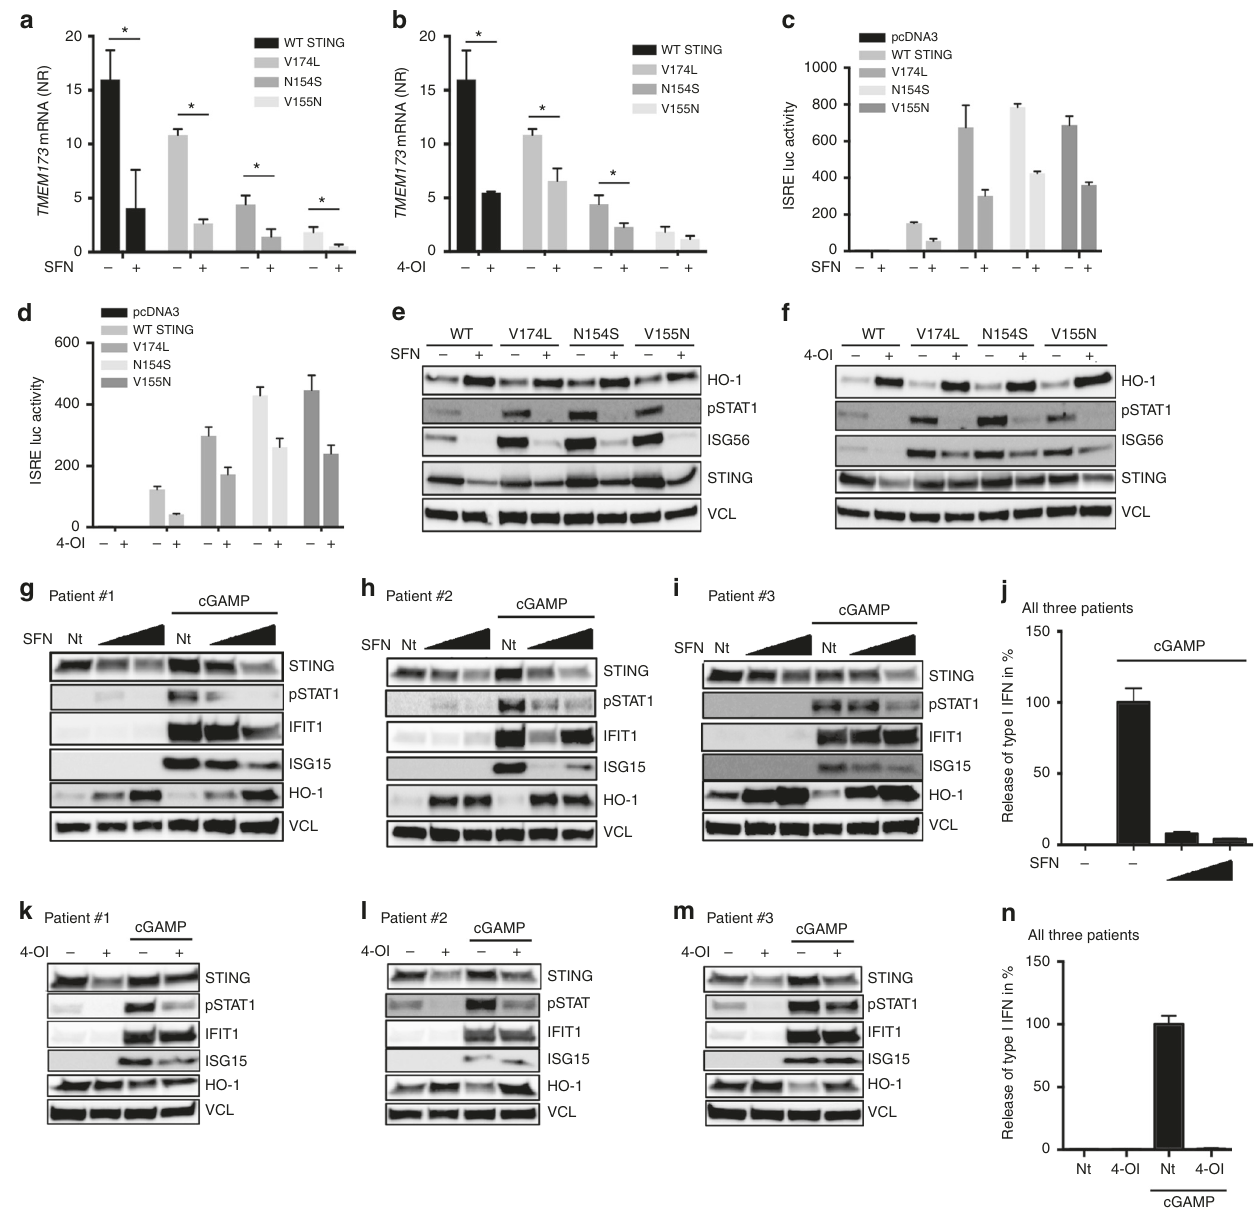
Fig. 5 Activation of Nrf2 suppresses STING-dependent type IFN response in fi broblasts from SAVI patients. a , b HEK293T were transiently transfected with human WT and SAVI-STING plasmids (V174L, N152S, or V155M) (500 ng/mL). Cells were treated 1 h prior transfection with SFN (10 μ M) or 4-octyl- itaconate (4-OI) (200 μ M). TMEM173 mRNA levels were assessed by qPCR. Data are the means ± s.e.m. of one experiment performed in quadruplicate. c